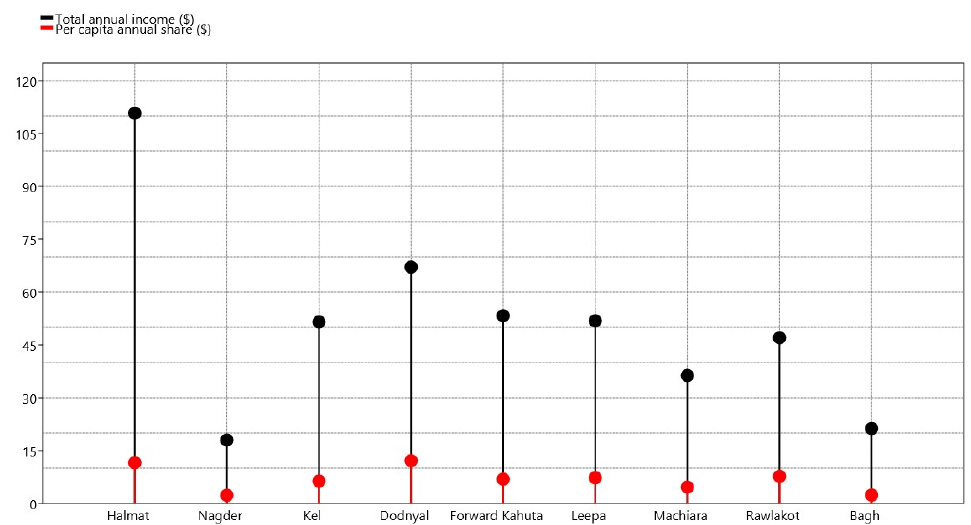
Figure 1. Annual per family as well as per capita income (in US $) generated specifically by common bean cultivation by the farmers in the AJK region.